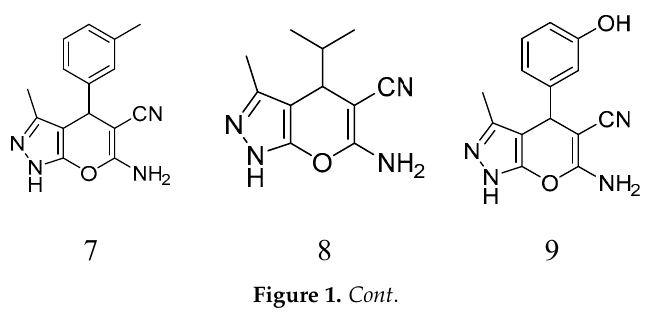
Figure 1. Cont Figure 1. Structure of compounds 1–9.